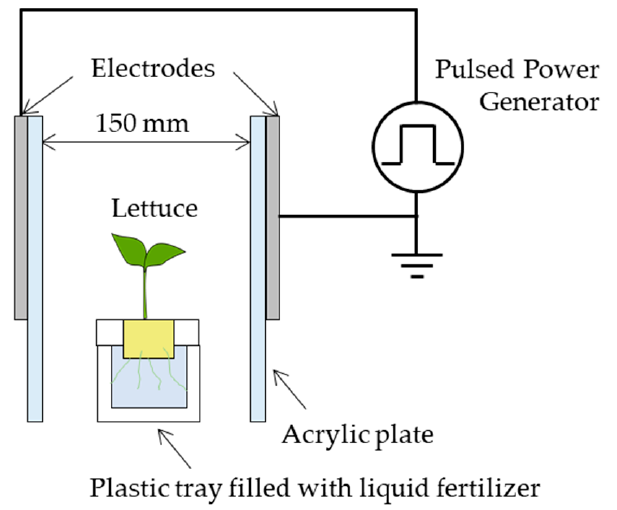
Figure 2. Schematic diagram of PEF treatment system. One lettuce plant with roots immersed in liquid fertilizer was placed between parallel plate electrodes, and a pulsed voltage was applied between the electrodes by a pulsed power generator connected to the electrodes. The plate electrodes are 150 mm × 150 mm × 4 mm stainless steel plates, and a 5 mm-thick acrylic plate was installed to prevent discharge between the electrodes. The distance between the electrodes was 150 mm.